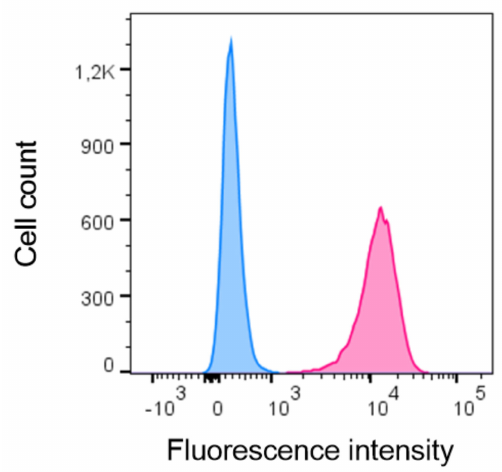
Figure 6. Subcloning of pgsB-618 cells results in HS + (pgsB-618 clone 19) and HS − (pgsB-618 clone 16) cells. The expression of HS on pgsB-618 clone 16 (blue) and pgsB-618 clone 19 (pink) cells was measured using flow cytometry with a primary anti-HS antibody and a secondary PE-labeled antibody. A histogram is shown with the cell count on the y-axis and the fluorescence intensity of the secondary antibody on the